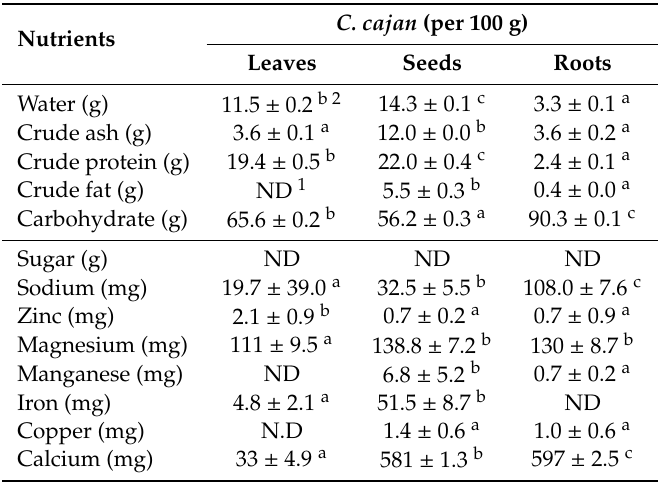
Table 1. The basic nutritional composition of leaves, seeds, and roots of C. cajan.